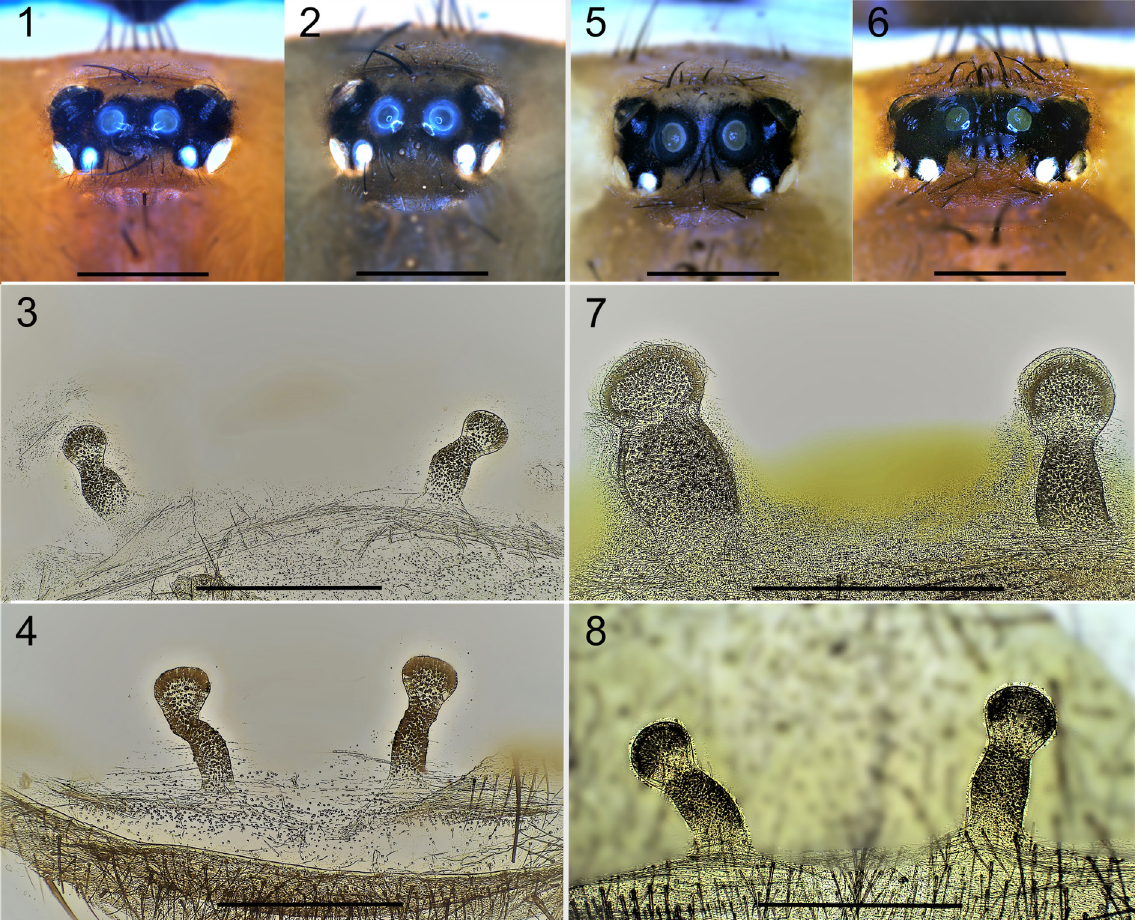
Figs 1–8. Characters reported to distinguish N. arboricola Pocock, 1903 from N. macrocephala Ausserer, 1871 in Kritscher (1994). 1–4 . N. arboricola ; represented by two specimens (TC.016, NHMR, Figs 1 & 3, specimen collected from an arboreal-nest; TC.017, NHMR, Figs 2 & 4, specimen